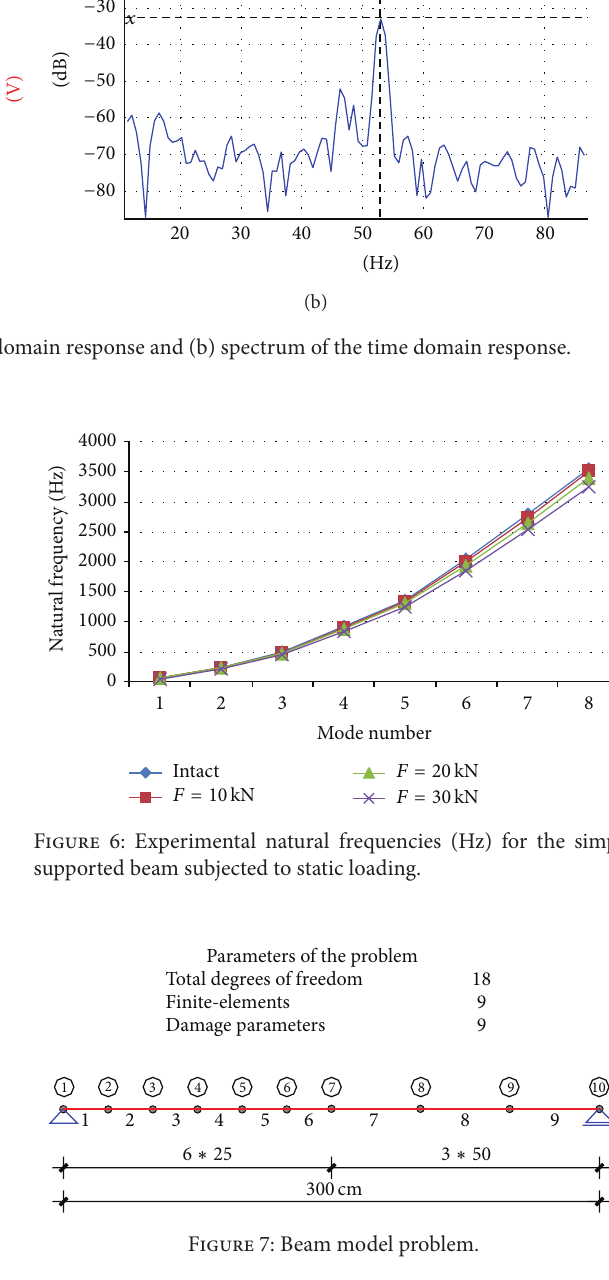
Figure 7: Beam model